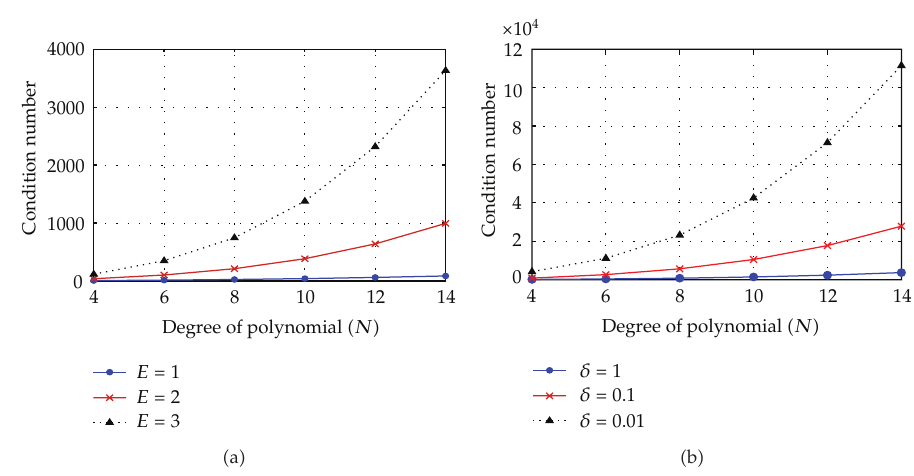
(cid:2) A (cid:2) (cid:5) 1 , 1 (cid:6) T . N 2 when b